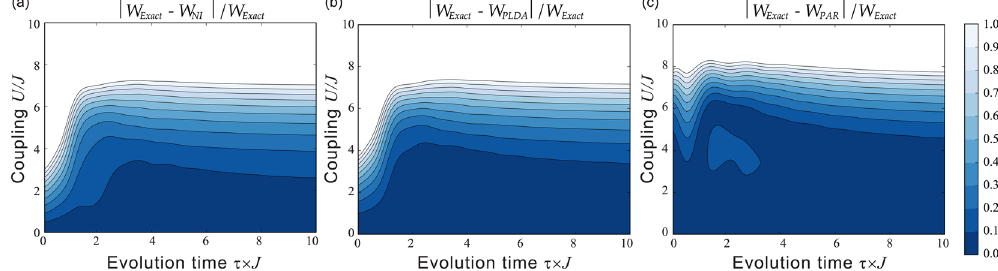
Figure 3. Relative error of the mean extracted work for the ‘zero-order’ perturbation protocol. Contour plot of the relative error is shown as function of the dimensionless particle-particle interaction strength U / J and the dimensionless evolution time τ × J . ( a ) Standard zero-order perturbation theory. ( b ) KS-based